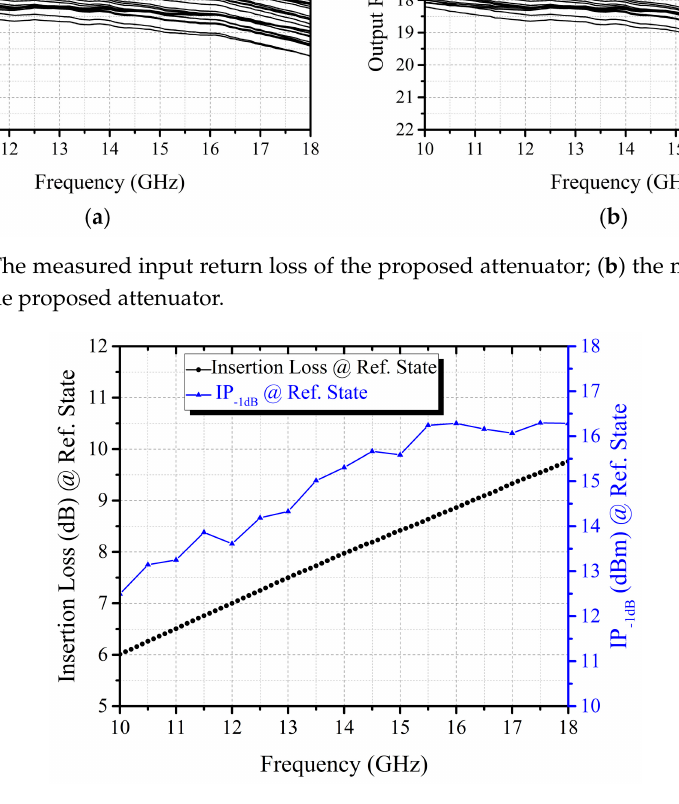
Figure 13. The measured 64-state relative attenuation and phase of the proposed attenuator.